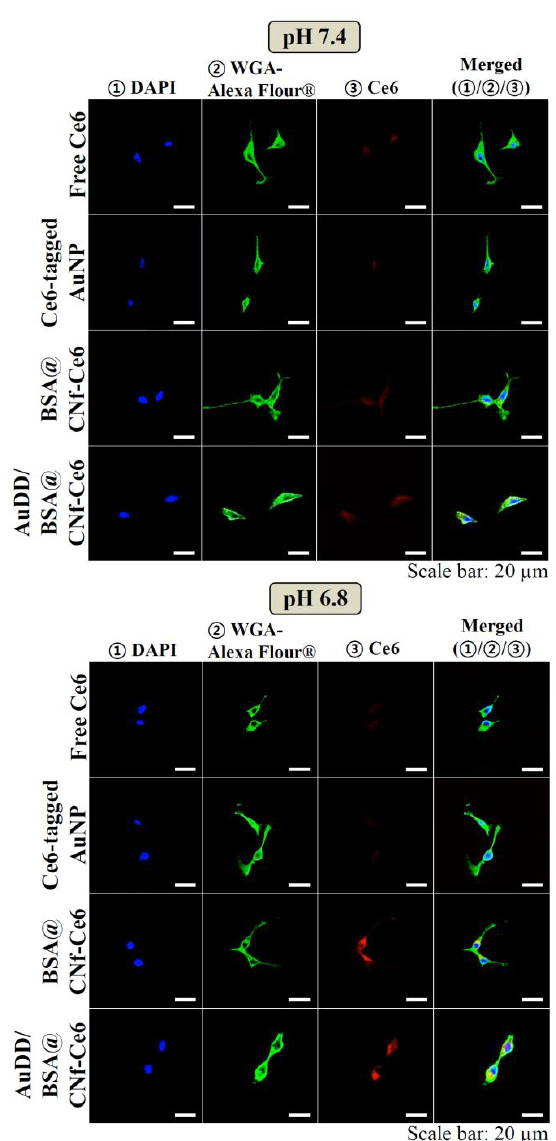
Figure 6. Confocal images of the MDA-MB-231 cells treated with free Ce6, Ce6-tagged AuNP,